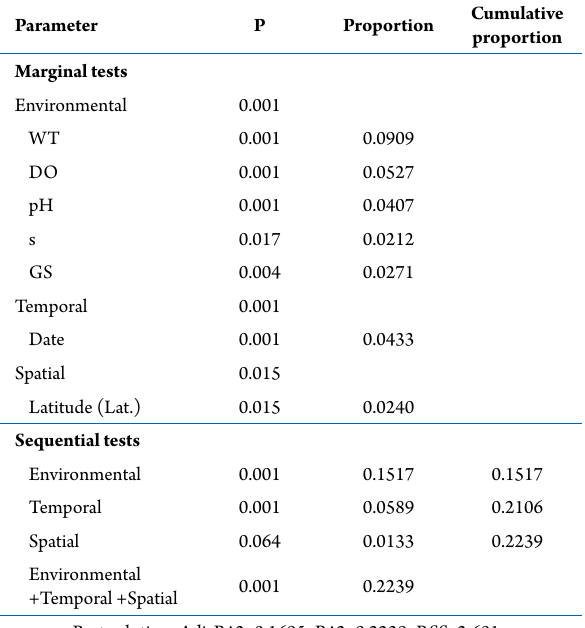
Table 6. The results of DistLM analyses.